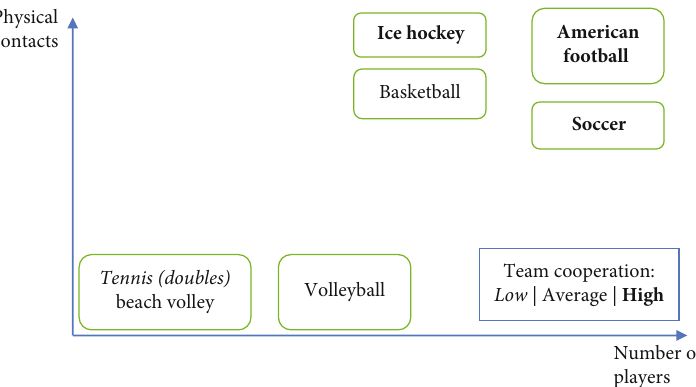
Figure 1: Features of particular team sports in 3 dimensions: number of players, physical contacts, and importance of team cooperation. Sports written in boldface require the highest team cooperation levels. Here, American football has the highest levels in all three